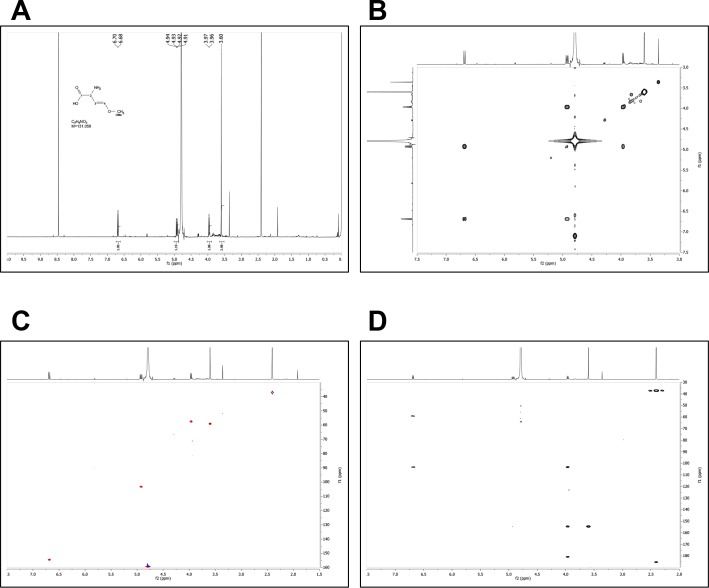
Characterization of the fraction F37 by NMR.(A) 1H NMR spectrum of F37 at 600 MHz in D2O. (B) COSY NMR spectrum of F37 in D2O. (C) Edited HSQC NMR spectrum of F37 in D2O. (D) HMBC NMR spectrum of F37 in D2O.